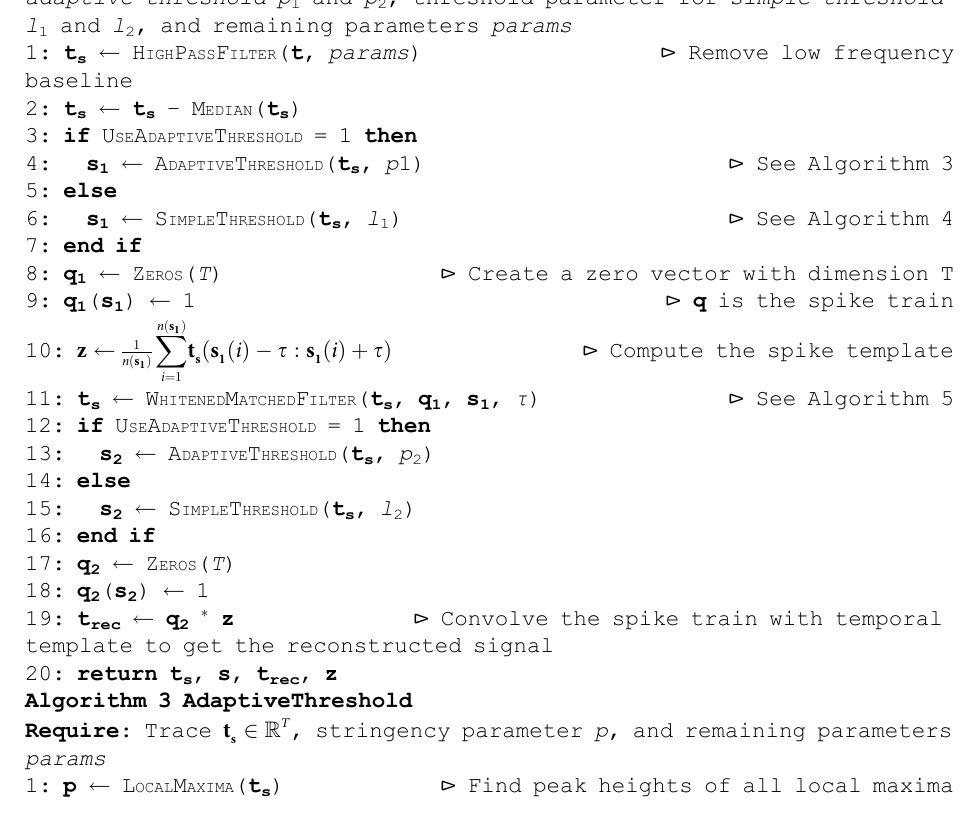
Algorithm 2 DenoiseSpikes